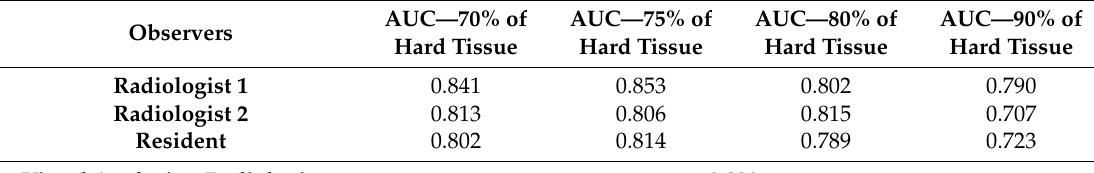
Table 1. Classification with different cut-off point. AUC—area under the